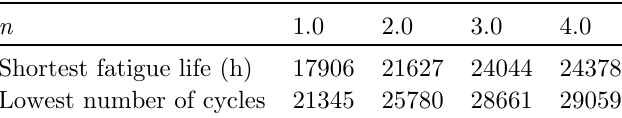
Fig. 11. Turbine disk stress distribution diagram with different values of parameter n : (a) n = 0.5, (b) n = 1.5, (c) n = 2.5, and (d) n = 3.5. Table 11. Von Mises stress at characteristic nodes of turbine disc for different n values.